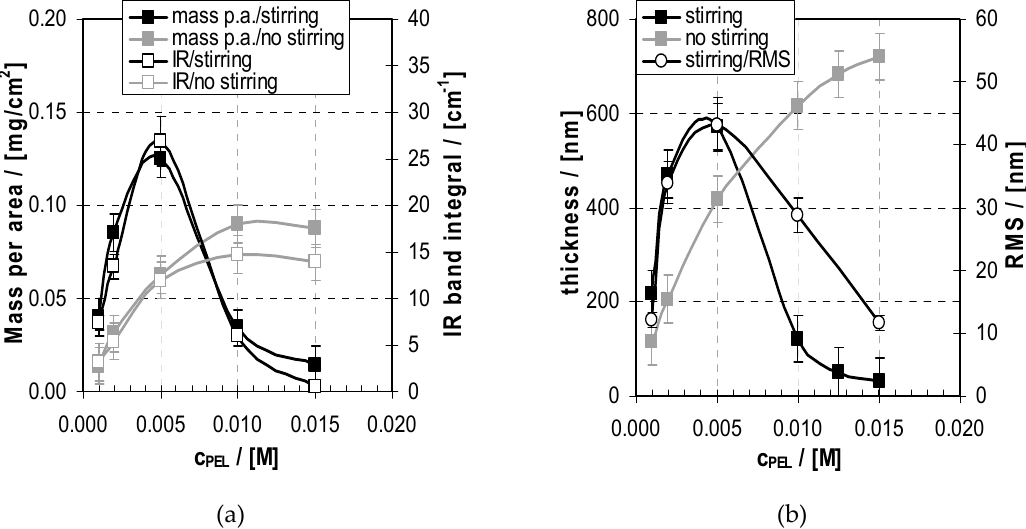
Figure 5. ( a ) Mass per area (left y -axis, full symbols) and integrated band area (1750–1425 cm − 1 ) obtained by transmission IR (right y -axis, open symbols) of PEM-10 in relation to c PEL obtained by the dipping method and no drying after each rinsing step with (grey) and without stirring (black). ( b ) Thickness (left y -axis) of PEM-10 in relation to c PEL obtained by the dipping method and no drying after each rinsing step with (black cubes) and without stirring (grey cubes). Roughness values (RMS, right y -axis) of PEM-10 are included for the stirring case (open circles).